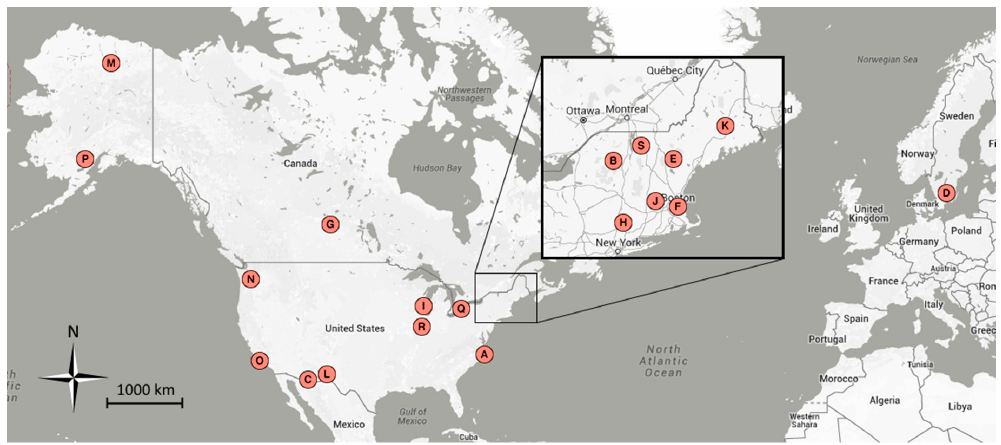
Figure 4. Map of PhenoCam sites used in Season Spotter. See Table 1 for site descriptions.